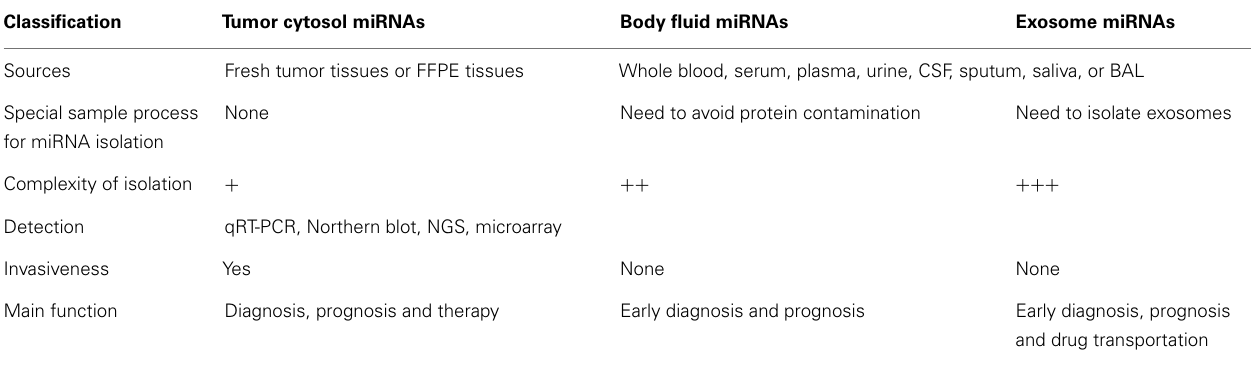
Table 2 |The isolation and detection of tumor cytosol, body fluid and exosome miRNAs .